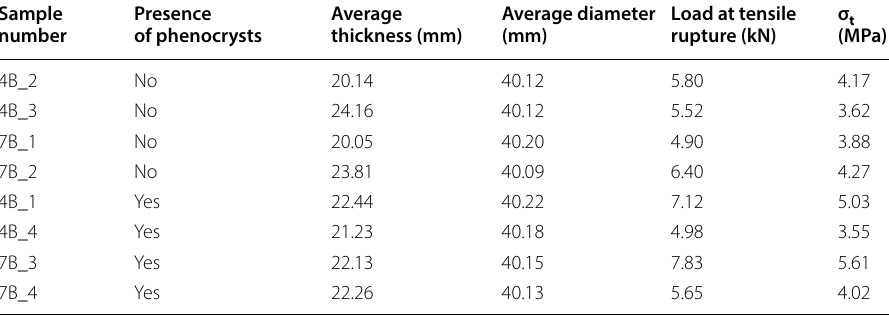
σ t —indirect tensile strength (calculated using Eq. 2)